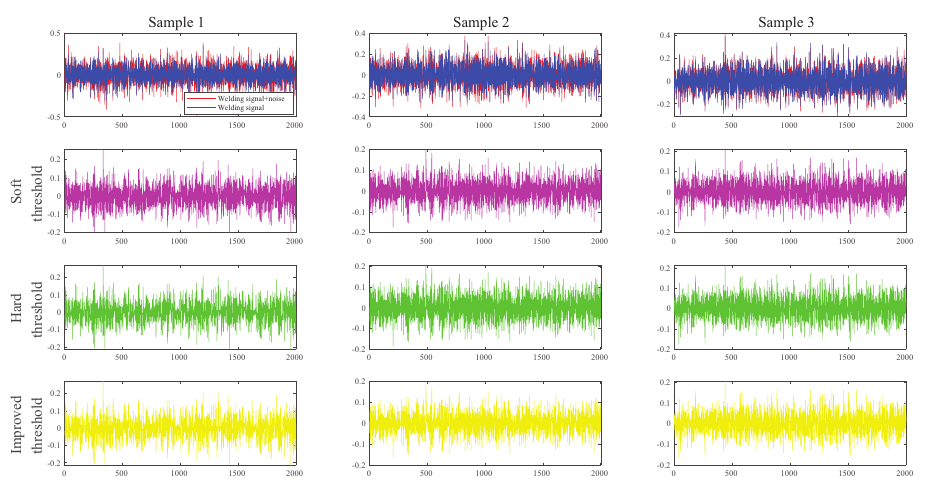
Figure 7. Comparison of wavelet denoising results for three random samples with different signal-to- noise ratios (Row 1: original signal; Row 2: soft threshold wavelet filtering; Row 3: Hard threshold wavelet filtering; Row 4: Improved valence wavelet filtering). The measured signal was decomposed using a three-layer wavelet, and the signal was